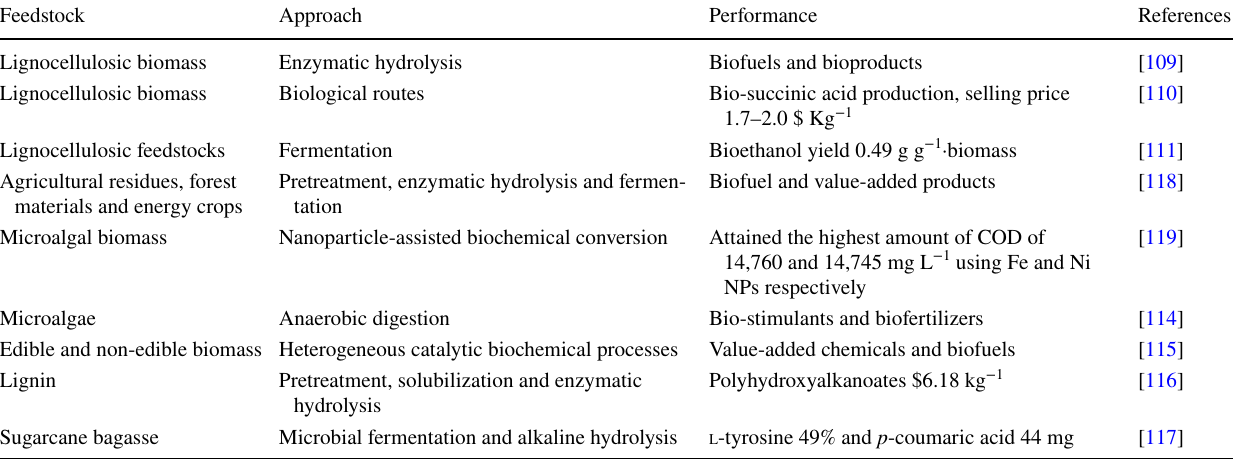
Table 1 Biochemical conversion to energy and materials